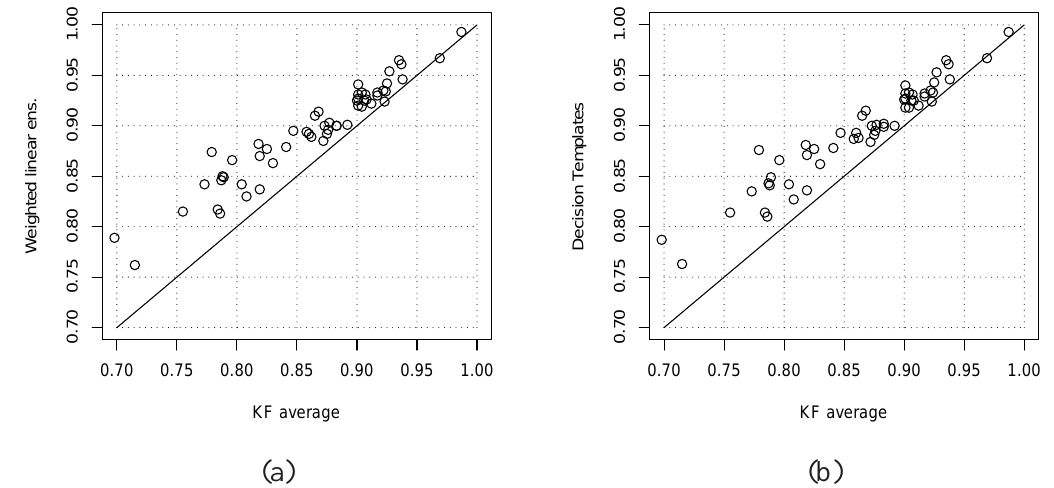
Figure 2: Comparison of AUC results between average kernel fusion and ensemble data integra- tion methods with 1 noisy data set. Points represent the AUC score of kernel fusion (abscissa) and ensemble (ordinate) methods for 56 GO terms. (a) Average KF vs Weighted ensembles (b) Average KF vs Decision